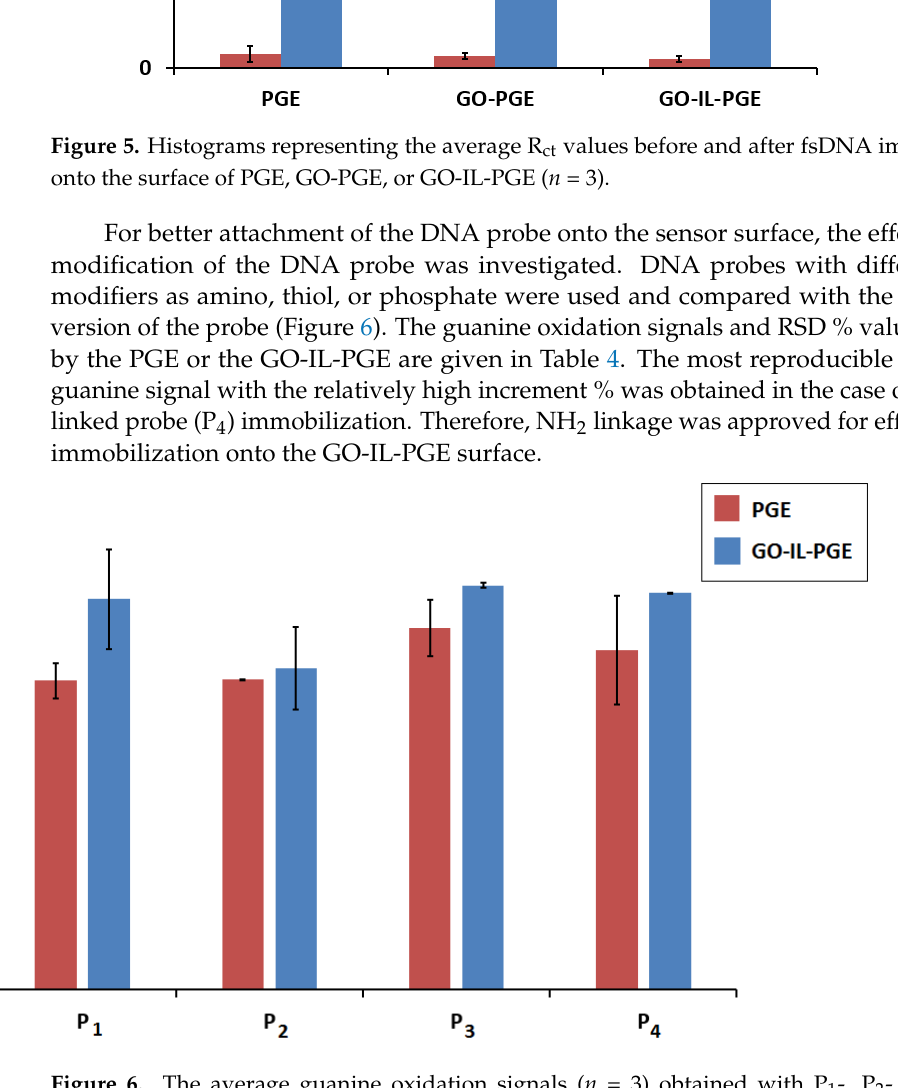
Figure 6. The average guanine oxidation signals ( n = 3) obtained with P 1 -, P 2 -, P 3 -, and P 4 -immobilized PGE and GO-IL-PGE. Table 4. The average guanine oxidation signals ( n = 3) and RSD % values recorded by PGE or GO- IL-PGE in case of immobilization of probe (P 1 ), -SH linked (P 2 ), -PO 4 linked (P 3 ), and -NH 2 linked probe (P 4 ). Increase % values were calculated by computing the difference between the signals recorded by PGE and GO-IL-PGE and comparing that difference to the signal recorded by PGE.